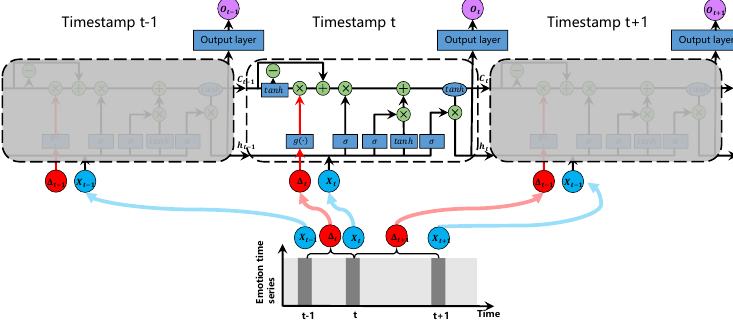
Figure 6. Illustration of the time-aware long-short term memory (T-LSTM) unit. First, using the memory of the previous moment, the short-term memory is obtained through the network. Note that this decomposition operation is data-driven, and its parameters are learned at the same time as the rest of the network parameters by back- propagation. After the short-term memory c s is computed, considering that the effect of t short-term memory is also related to the time gap, a time decay function g ( ∆ t ) is used to calculate the weight and adjust short-term memory to obtain the discounted short-term memory ¯ c s . Finally, to compose the adjusted previous memory back c ∗ , the complement t t − 1 subspace of the long-term memory c L is combined with the discounted short-term t − 1 memory. The detailed mathematical expressions of the T-LSTM network in Figure 6 are given by Equations (3)–(8)